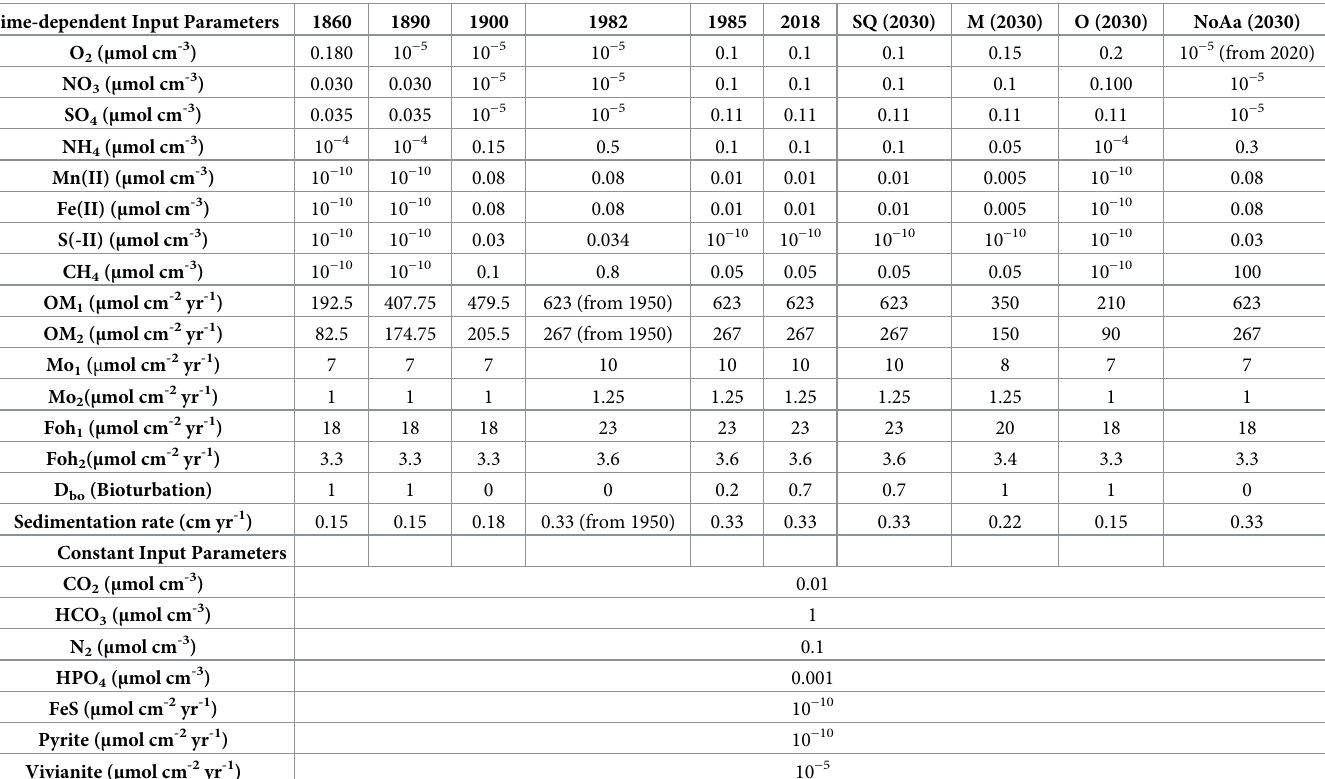
Table 1. Upper boundary conditions used for the simulated soluble and solid species in the various scenarios defined in section 2.8. For solutes, these are the concen- trations in the bottom boundary layer above the DBL, for solids the depositional fluxes. Between the dates given here, values were linearly interpolated. Time-dependent Input